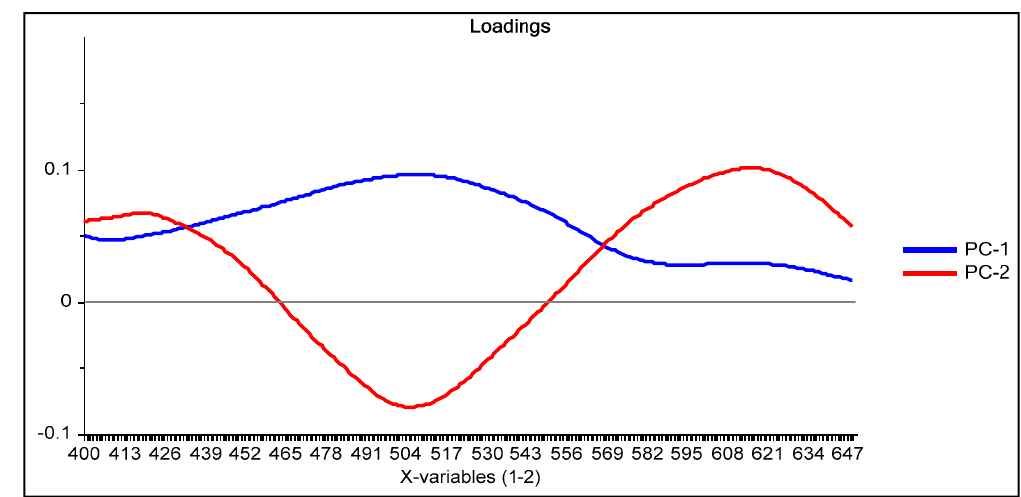
Figure 3. Loading graph of the principal component analysis (PCA) reduction for the system Dz-Hg(II) using the M1 process method of analysis.